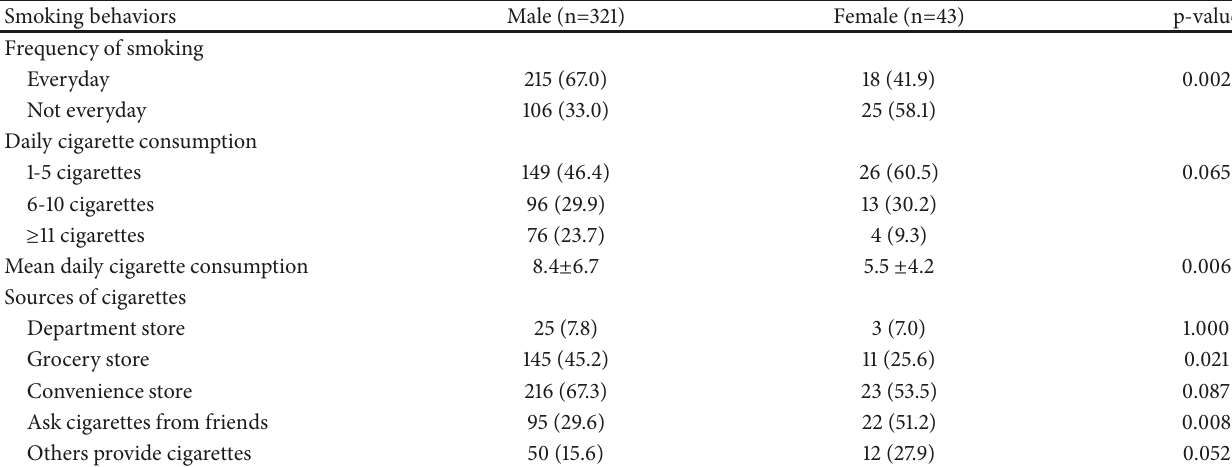
Table 2: Differences of smoking behaviors between males and females (n=364).